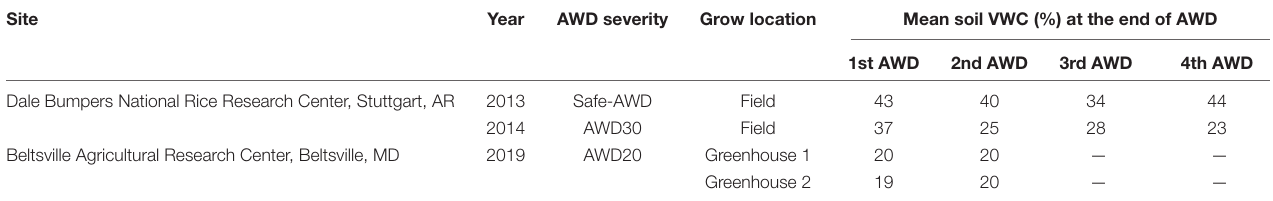
TABLE 1 | Severity of alternate wetting and drying (AWD) treatment and mean soil volumetric water content (VWC, %) at the end of each AWD cycle by experiment. Site Year AWD severity Grow